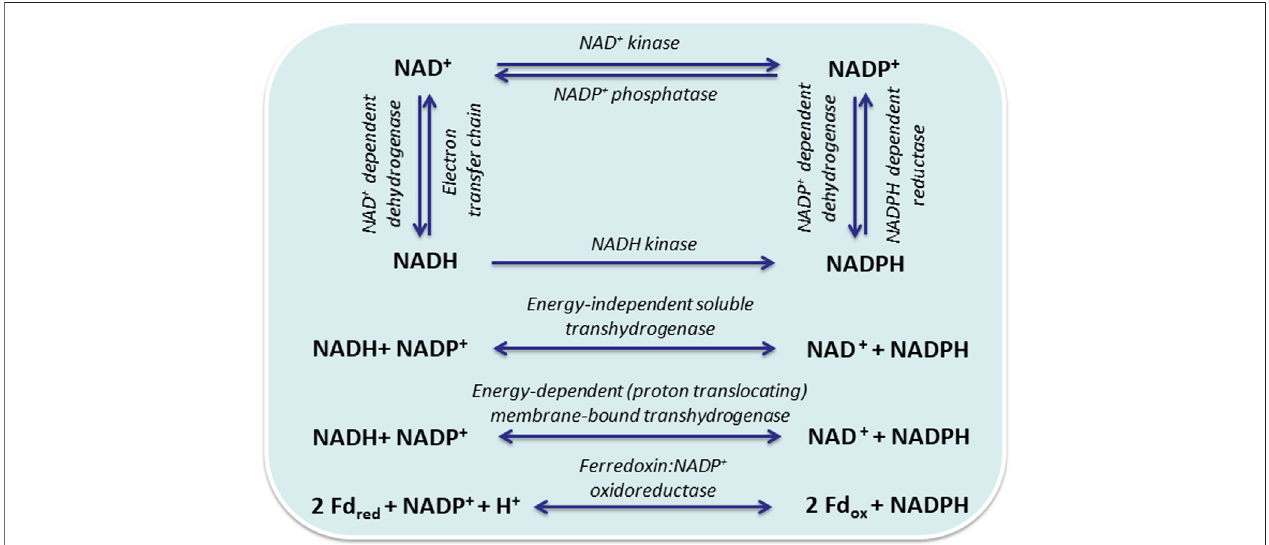
FIGURE 1 | Interconversion and regeneration of redox equivalents via reactions that are not directly coupled to the central carbon metabolism: NAD + kinase (EC 2.7.1.23);NADHkinase(EC2.7.1.86),NADP + phosphatase(EC2.7.1.23);NAD + -dependentdehydrogenase(EC:1.12.1.2);NADP(H) +